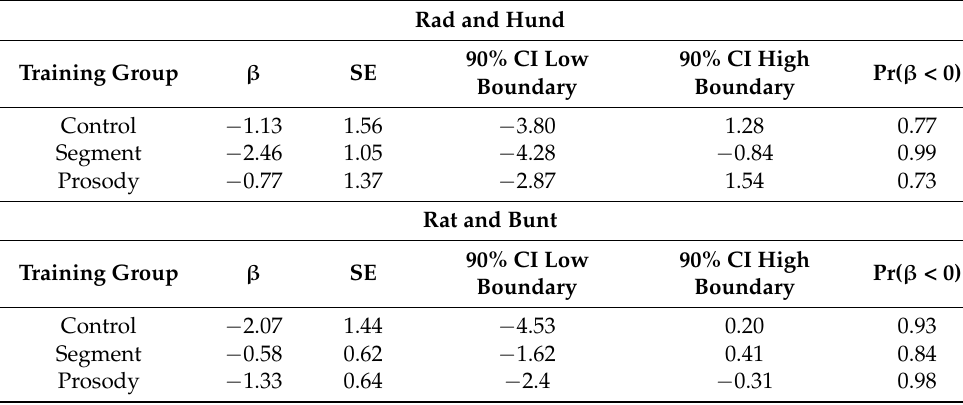
Table 5. Statistical results for epenthetic